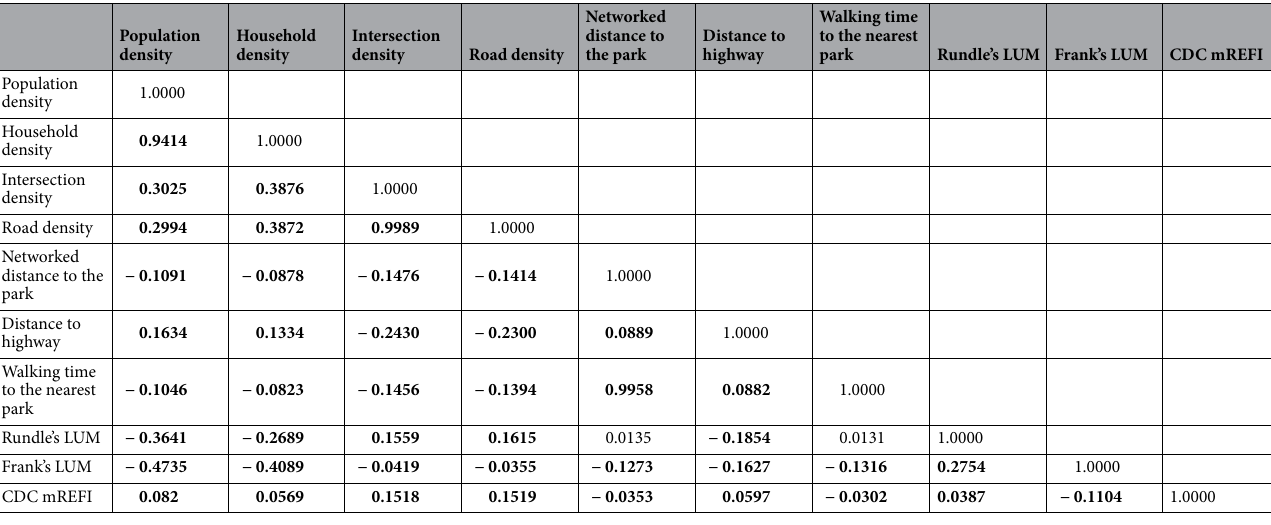
Table 2. Pair-wise correlations between built environment variables. All statistically significant correlations (P < 0.05) were in Bold.